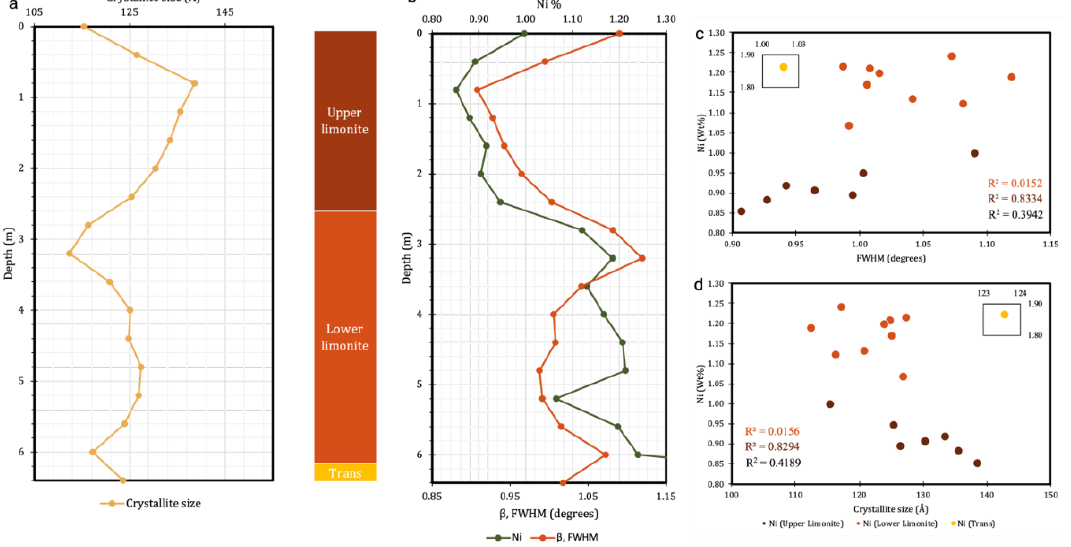
Figure 7. ( a ) Variations in crystallite size of goethite in the limonite and transition zones with depth, as calculated via Rietveld refinement. ( b ) Bulk Ni content and calculated full width at half maximum values of goethite in the limonite and transition zones with depth. ( c ) Relationship of bulk Ni content and full width at half maximum (FWHM) of goethite and ( d ) bulk Ni content and crystallite size of goethite in the limonite and transition zones. Further shown are the R 2 values of the samples from the upper limonite (red), lower limonite (orange), and whole limonite (black) zones.